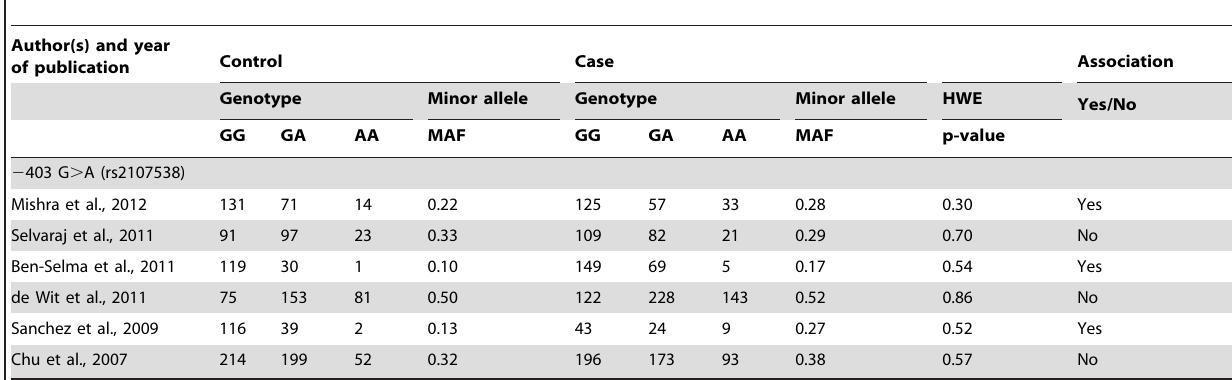
Table 2. Genotypic distribution of CCL5 -403 G . A gene polymorphism included in the meta-analysis.